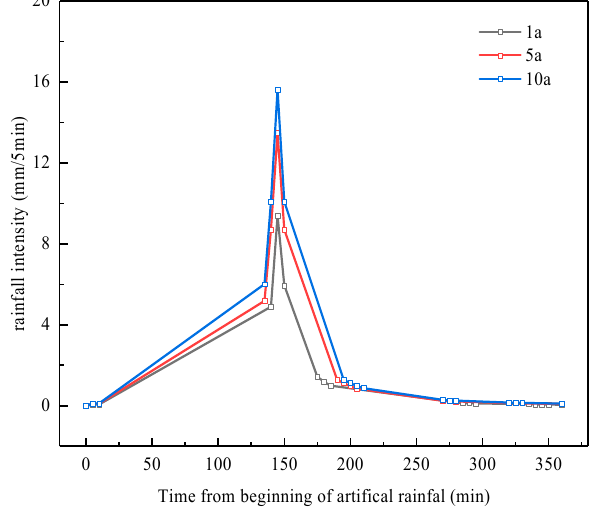
Figure 2. Artificial rainfall event design.